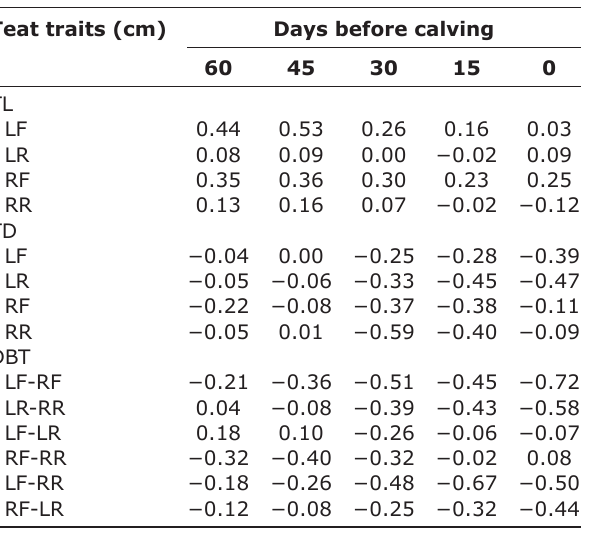
Table-5: Correlation coefficients between teat traits and DPY at different days of pregnancy in primiparous Nili-Ravi buffaloes. Teat traits